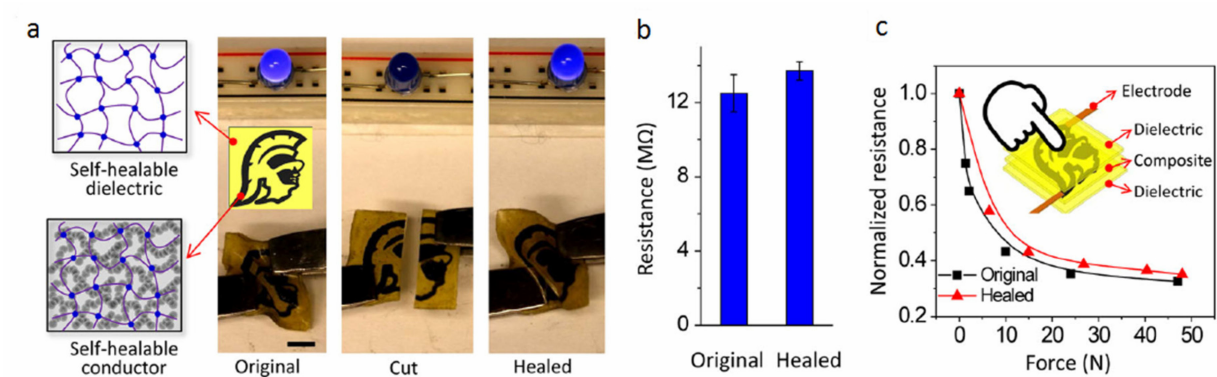
Figure 16. ( a ) A flexible Trojan pad with a self-healable elastomer phase and a self-healable conductor phase can power an LED. Once cut and healed after 4 h at 60 ◦ C, the self-healed Trojan pad can again sustain bending and power the LED. The scale bar represents 4 mm. ( b ) The resistance of the conductive path of the Trojan path before and after self-healing. ( c ) The correlations between the original and self-healed force sensors’ normalized resistances and applied force. Copyright 2019 Springer Nature. Reprinted with permission from ref.